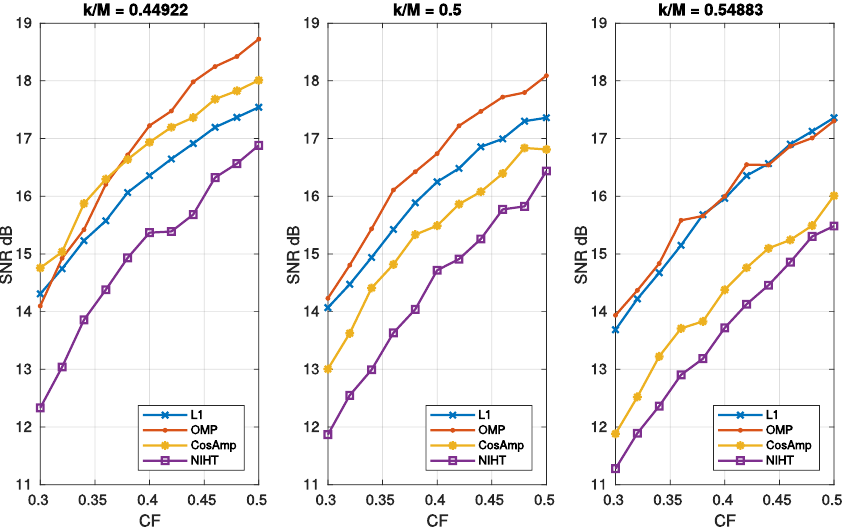
Figure 8. Case Study A—SNR as a function of compression factor CF = M / N for the four algorithms and three values of sparsity S M = k / M . A value of SNR = 25 dB for the measurement signal y is